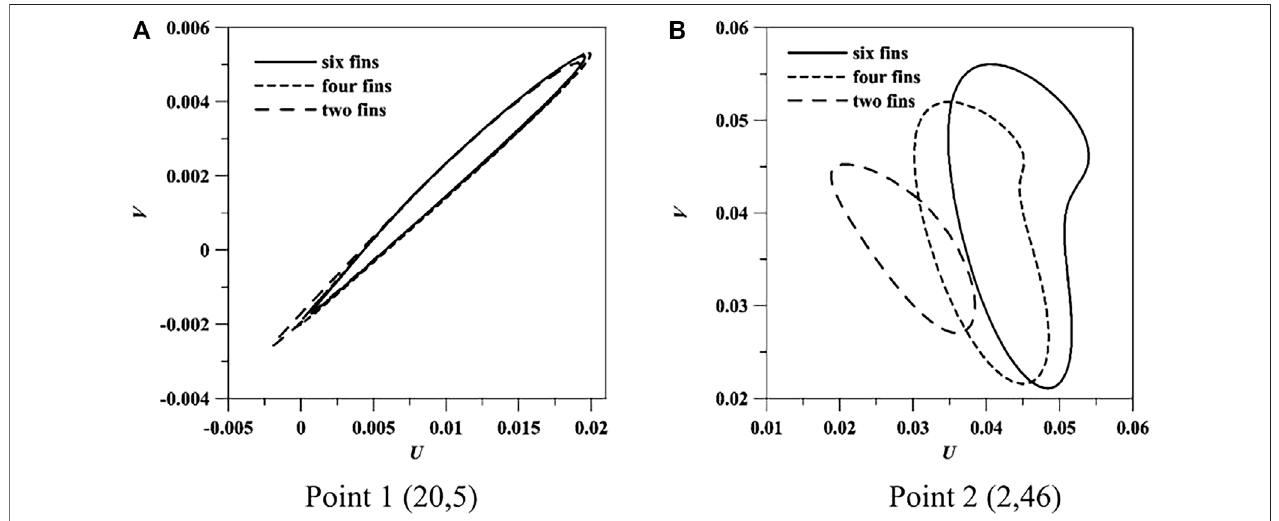
FIGURE 10 | Time signal of K eq for two fi ns with different positions. (A) Ra (cid:1) 2 × 10 5 (B) Ra (cid:1) 10 6 .